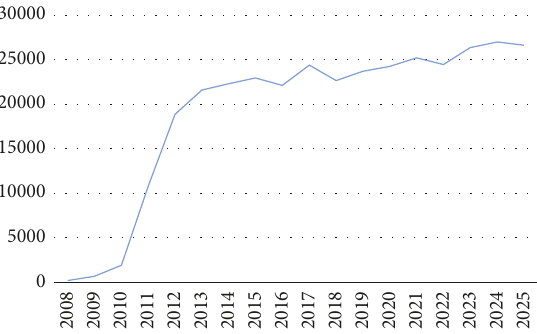
Figure 10: Solar energy supply in the USA by year, gigawatts per hour. Sources: IEA; author’s calculations.